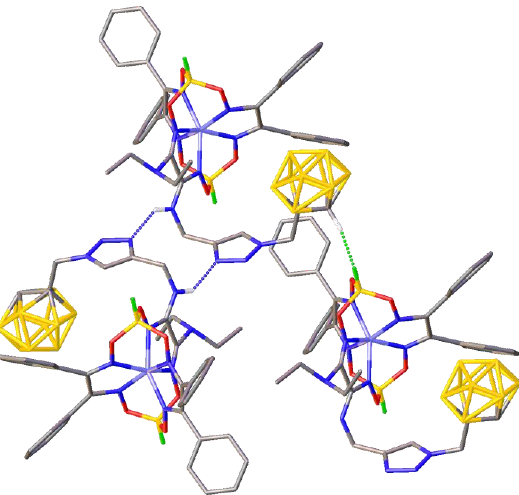
Figure 2. Fragment of a crystal packing of the complex 15 · C 6 H 6 . The intermolecular N–H . . . O and C–H . . . F interactions are depicted with blue and green dotted lines, respectively.